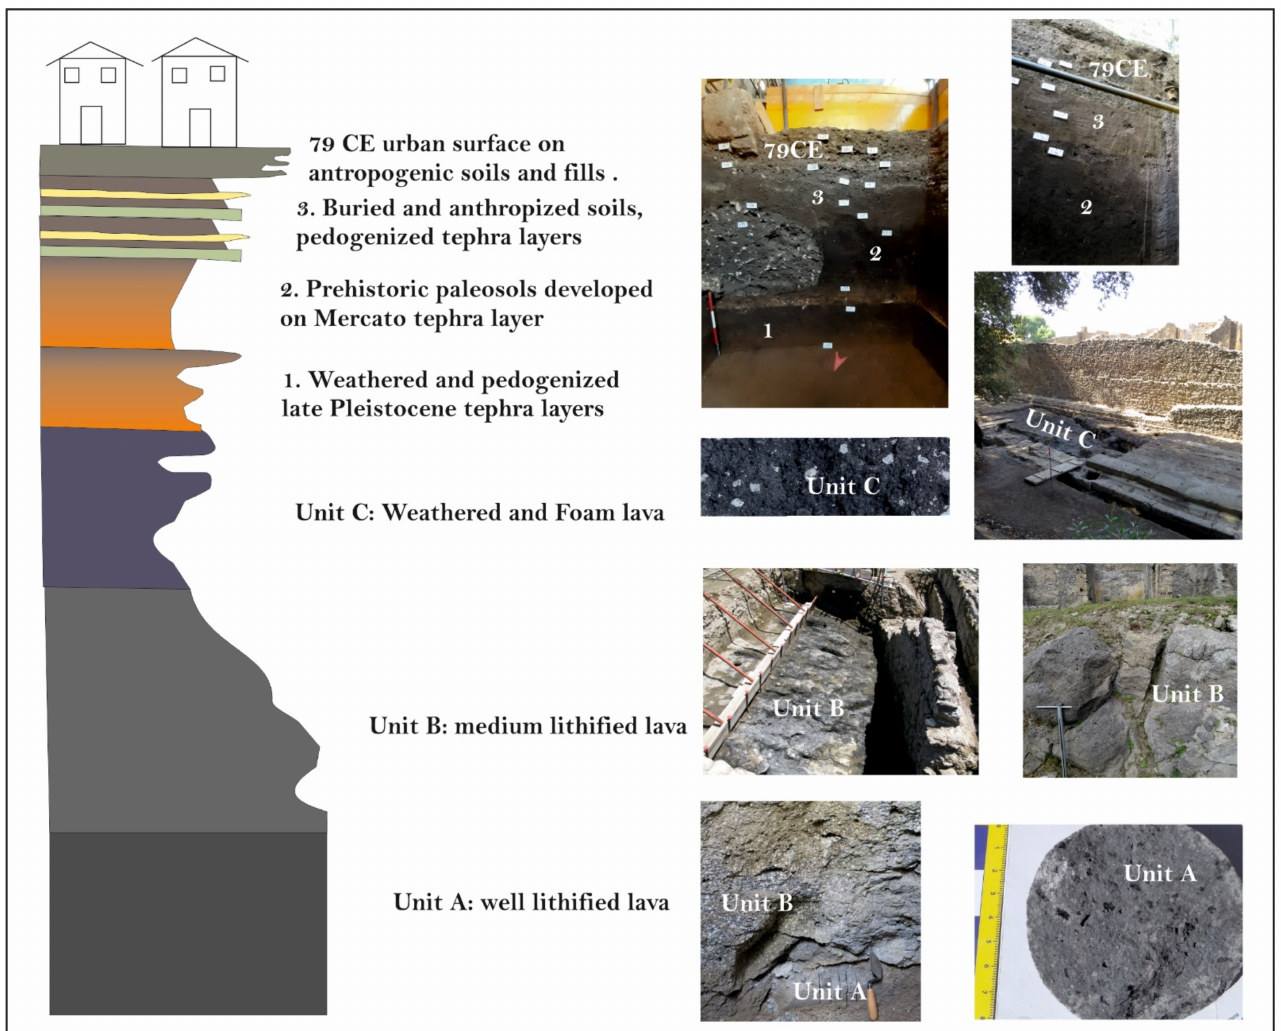
Figure 4. Schematic of the lithofacies log and related photos of the Pompeii subsoil units. Unit A consists of well-lithified lava, from a dark grey to grey colour, with porphyric assemblage of leucite, augite, sanidine and biotite phenocrists. The rock can be defined as basaltic trachyte-andesite [56,57]. The lithotecnical feature of the lava is good and the thickness also exceeds 15 m. Unit B, 2–3 m thick, presents intermediated features between the previous ones. Several outcrops of the lava successions are visible in the southern and western slopes of the volcanic hill where the Insulae meridionalis and occidentalis